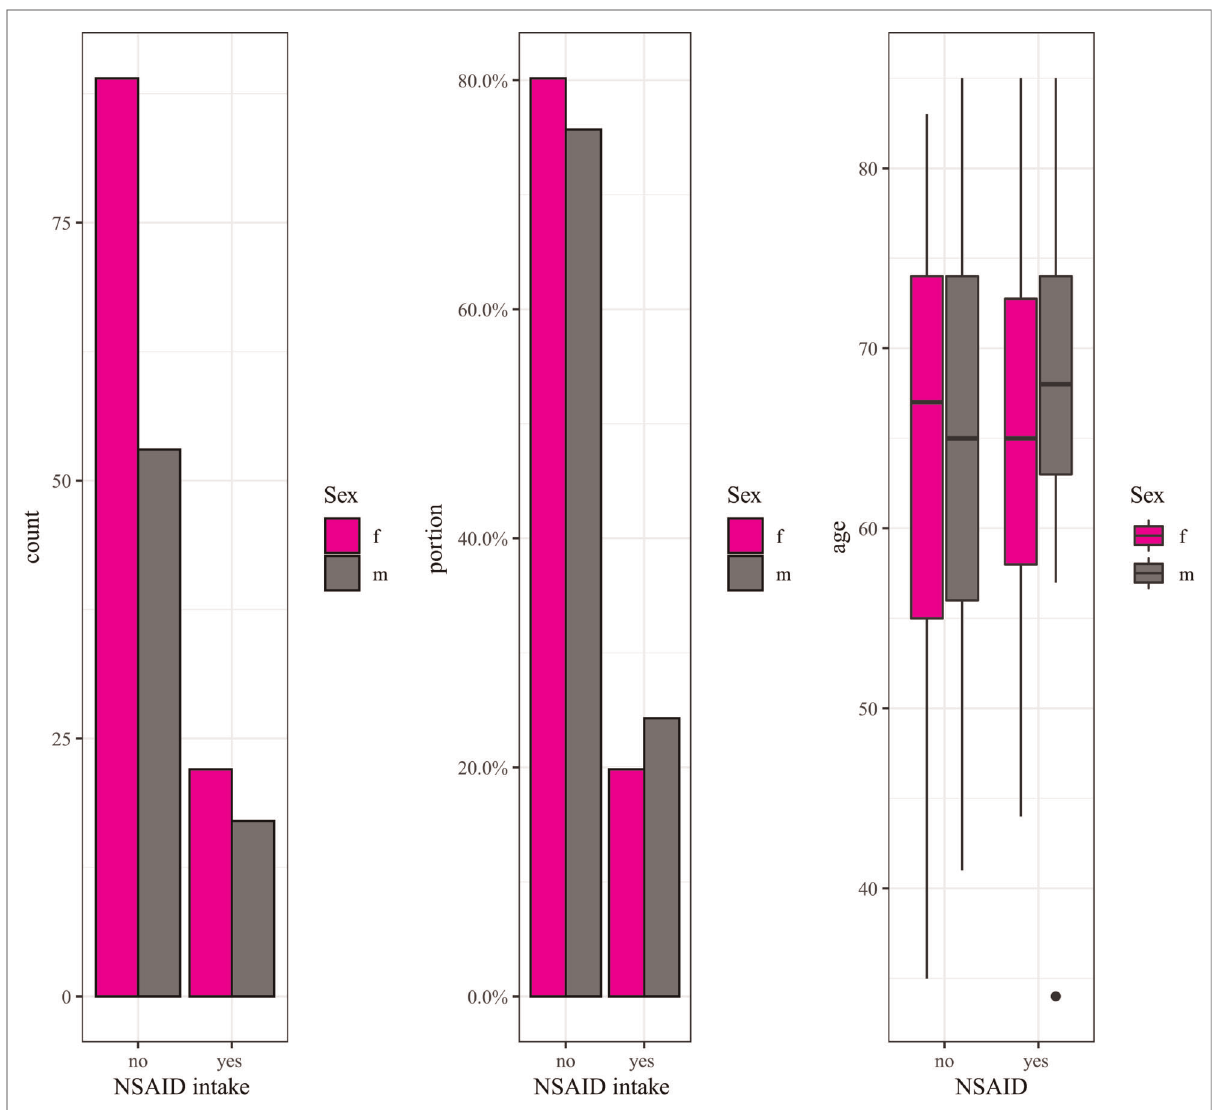
FIGURE 1 Number and percentage of patients in the NSAID and the non-NSAID group; age distributions in the two